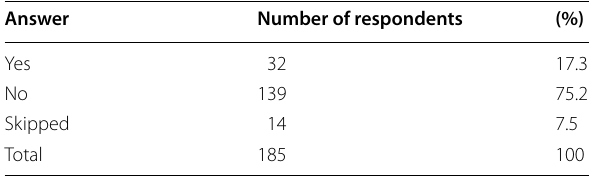
Table 9 Experience of 185 respondents with AI-based algorithms for clinical diagnostic interpretive tasks: Were patients informed that an AI software was used to reach the diagnosis?